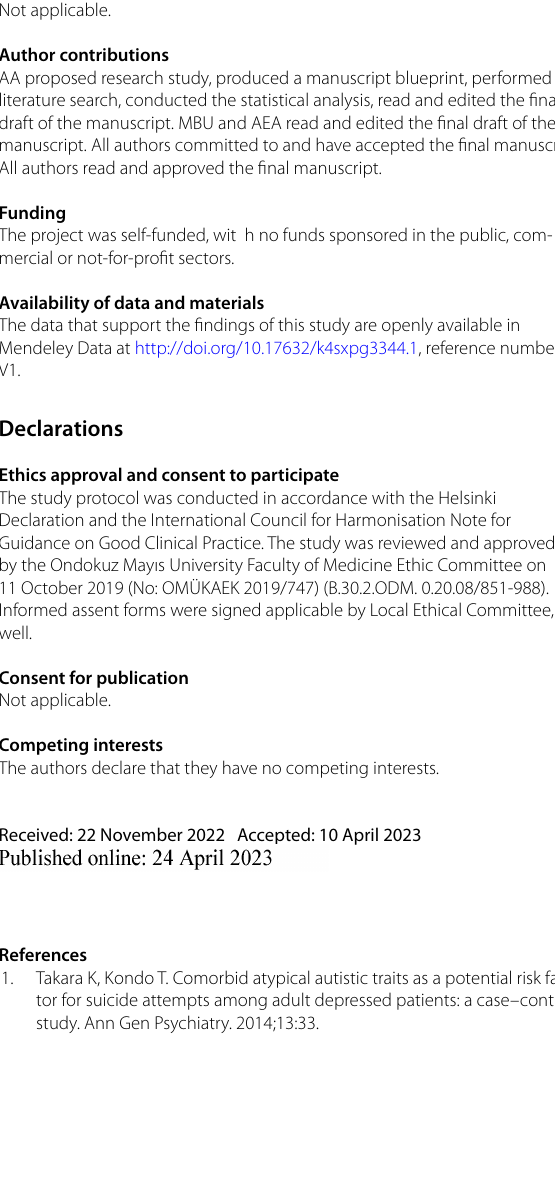
control groups. Table S5 . Comparison of CTQ scores between adolescents with and without self-harm. Table S6 . Comparison of CTQ scores within the group of self-harming